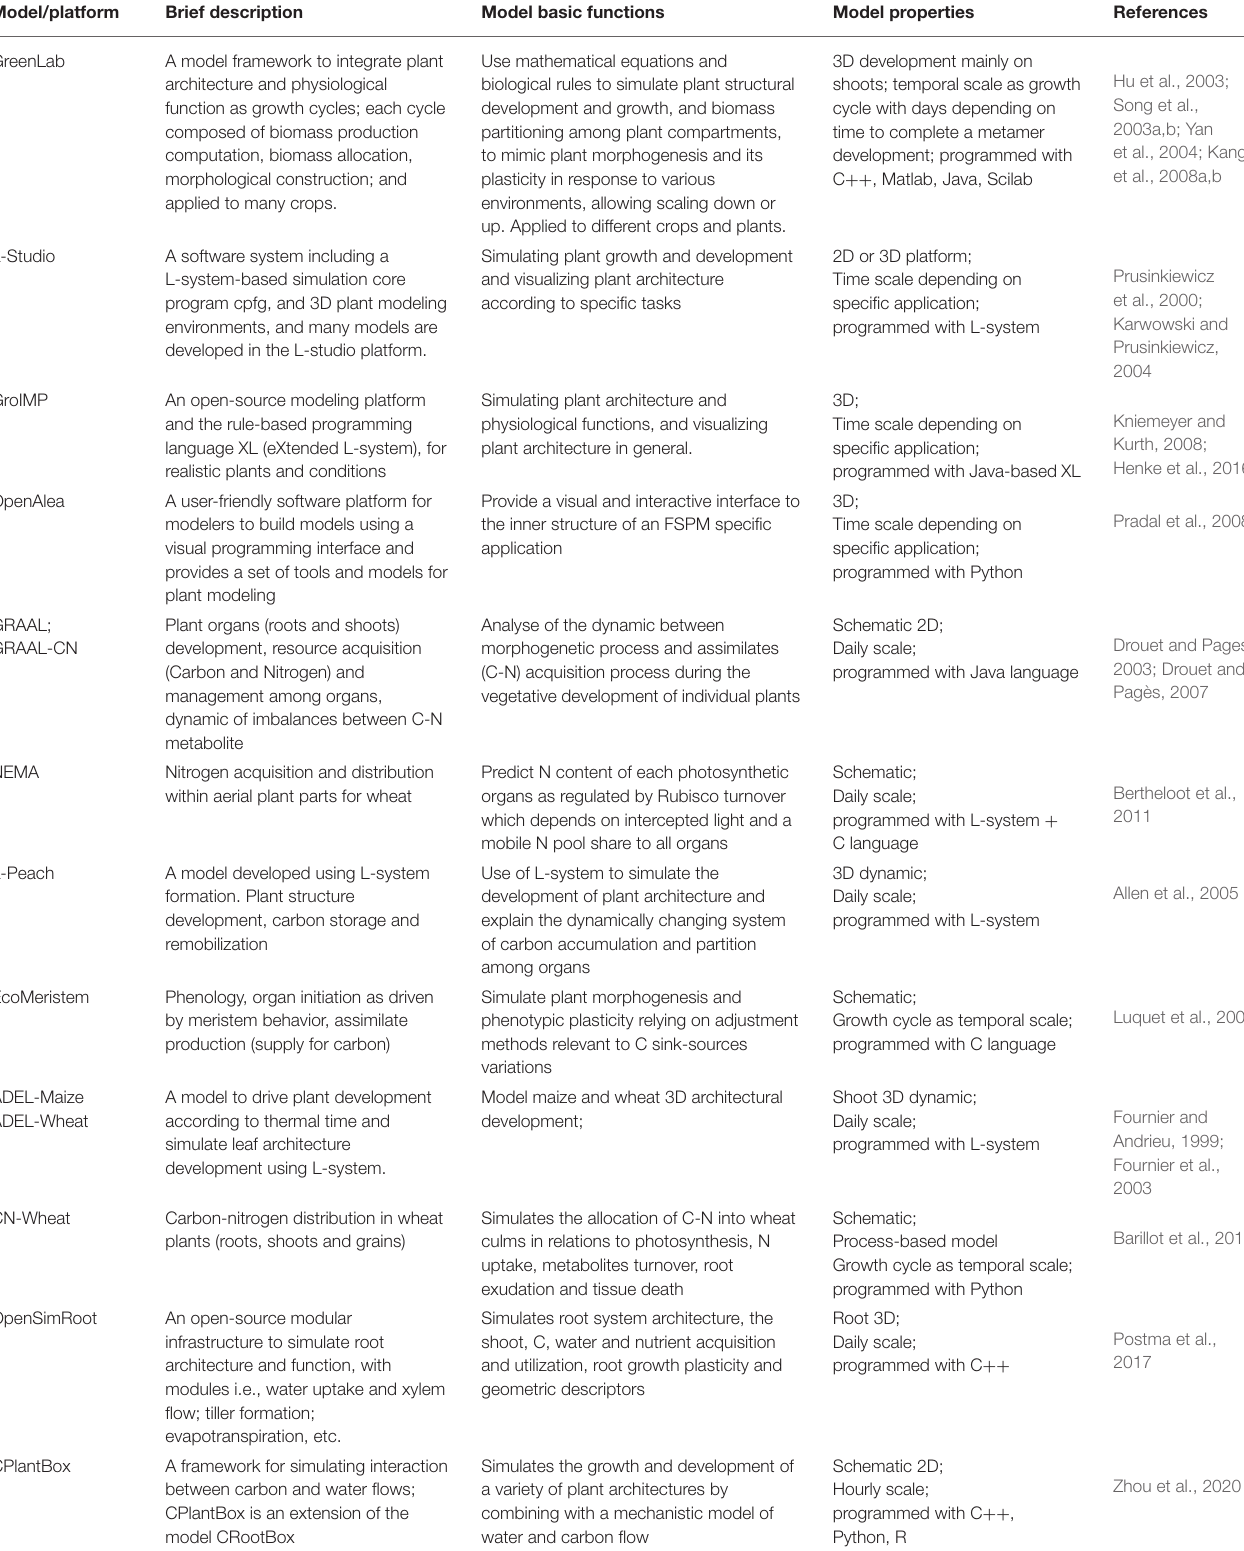
TABLE 1 | The list of functional–structural plant models/platforms, brief description of characteristics, and basic functions.